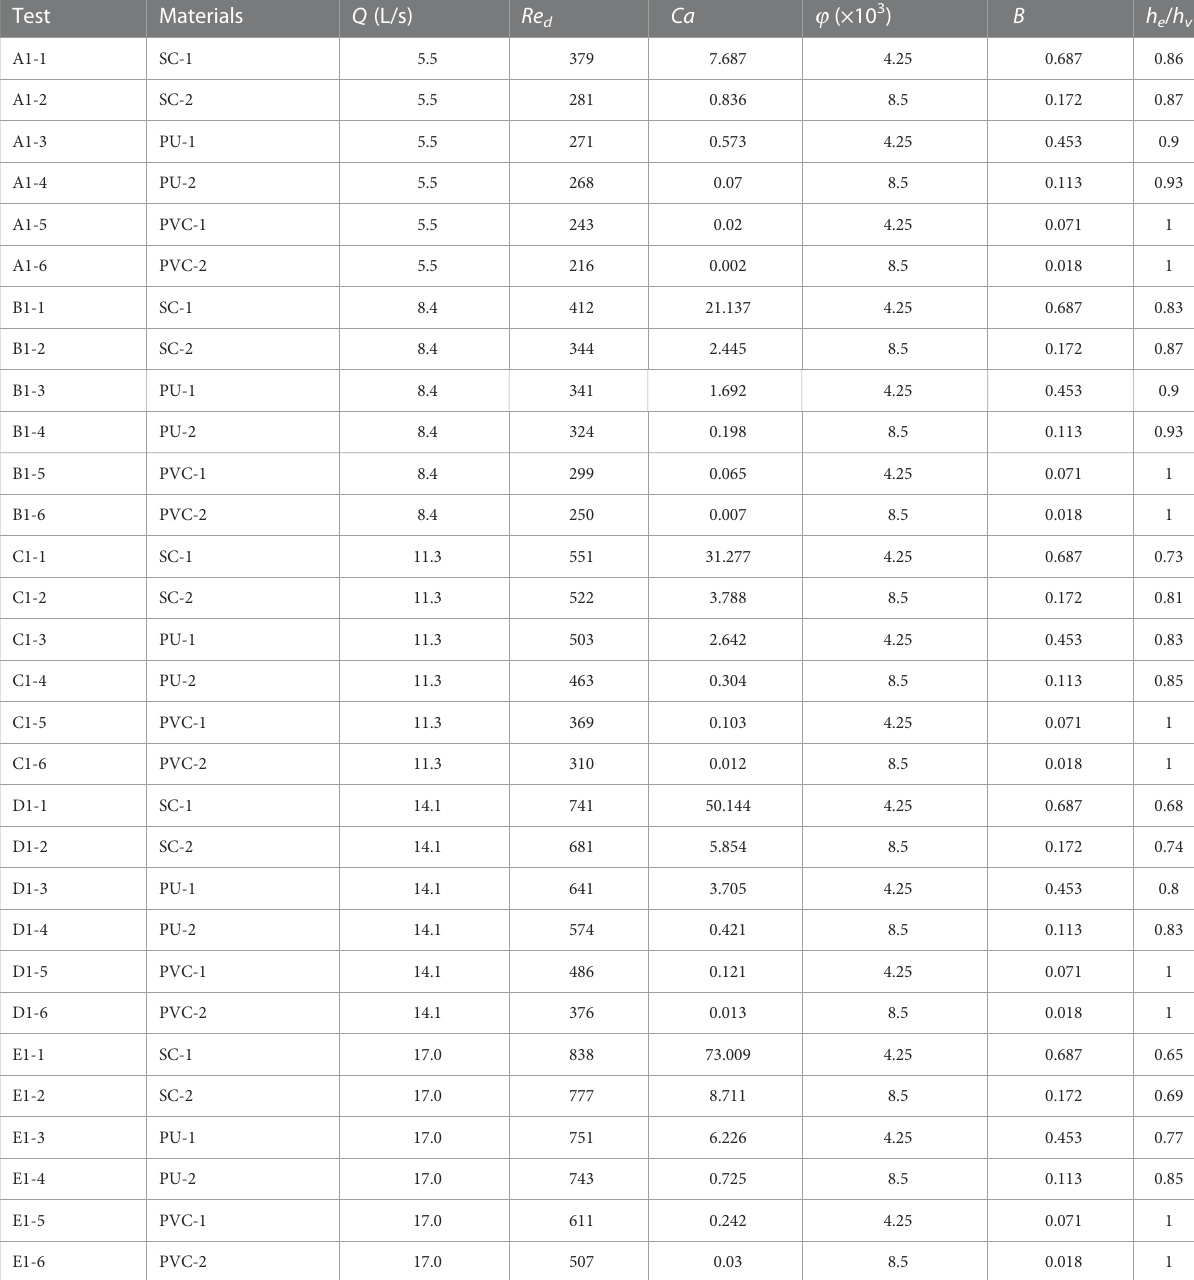
TABLE 2 Vegetation and fl ow parameters for each